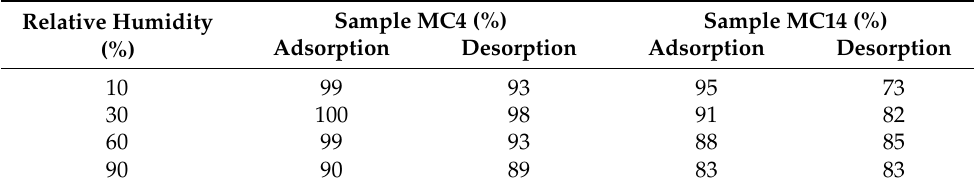
Table 2. EMC of the surface layer of the heat-treated samples expressed as the percentage of that of the control sample at 4 relative humidity levels.